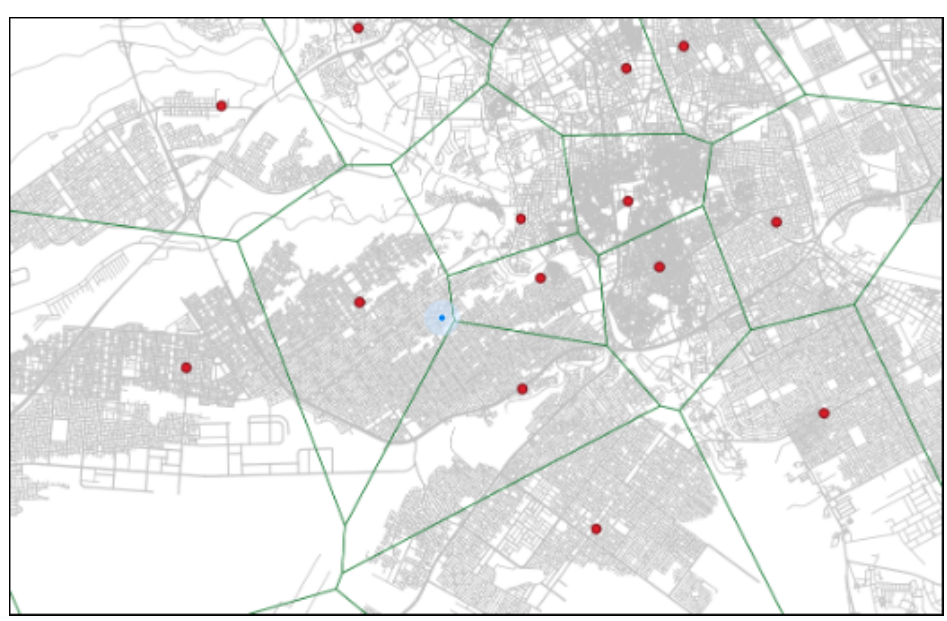
Figure 9. Catchment areas of Voronoi spatial